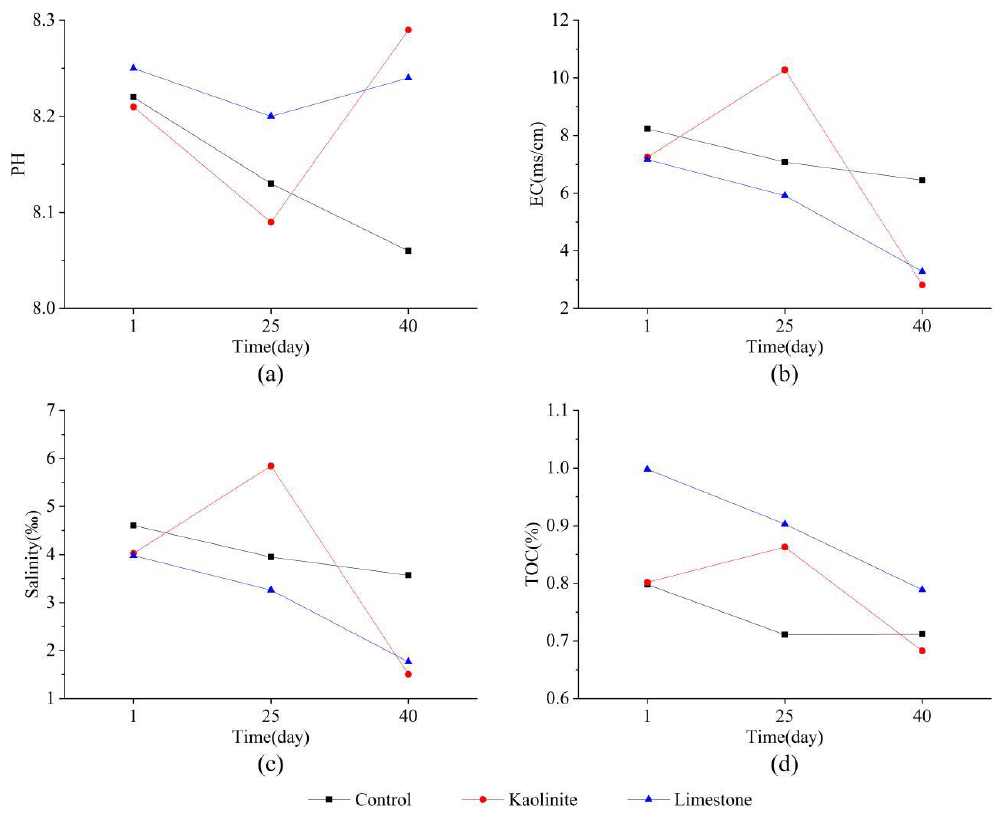
Figure 1. The properties of the sediment samples. ( a ) The pH values of the sediments in control, kaolinite and limestone groups with incubation time periods of 1 day, 25 days, and 40 days; ( b ) The EC values of the sediments in control, kaolinite and limestone groups with incubation time periods of 1 day, 25 days, and 40 days; ( c ) The salinity values of the sediments in control, kaolinite and limestone groups with incubation time periods of 1 day, 25 days, and 40 days; ( d ) The TOC values of the sediments in control, kaolinite and limestone groups with incubation time periods of 1 day, 25 days, and 40 days.